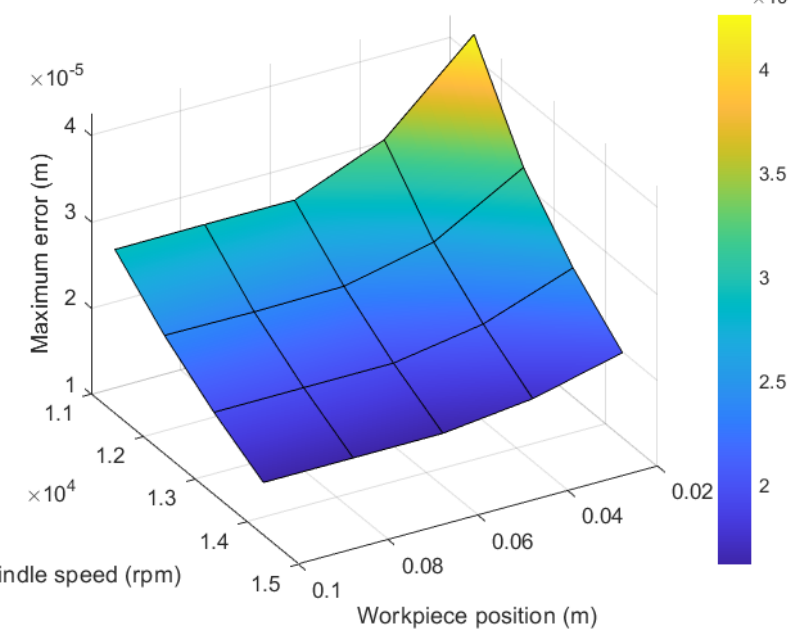
Figure 11. Maximum error possible for spindle with external motor.